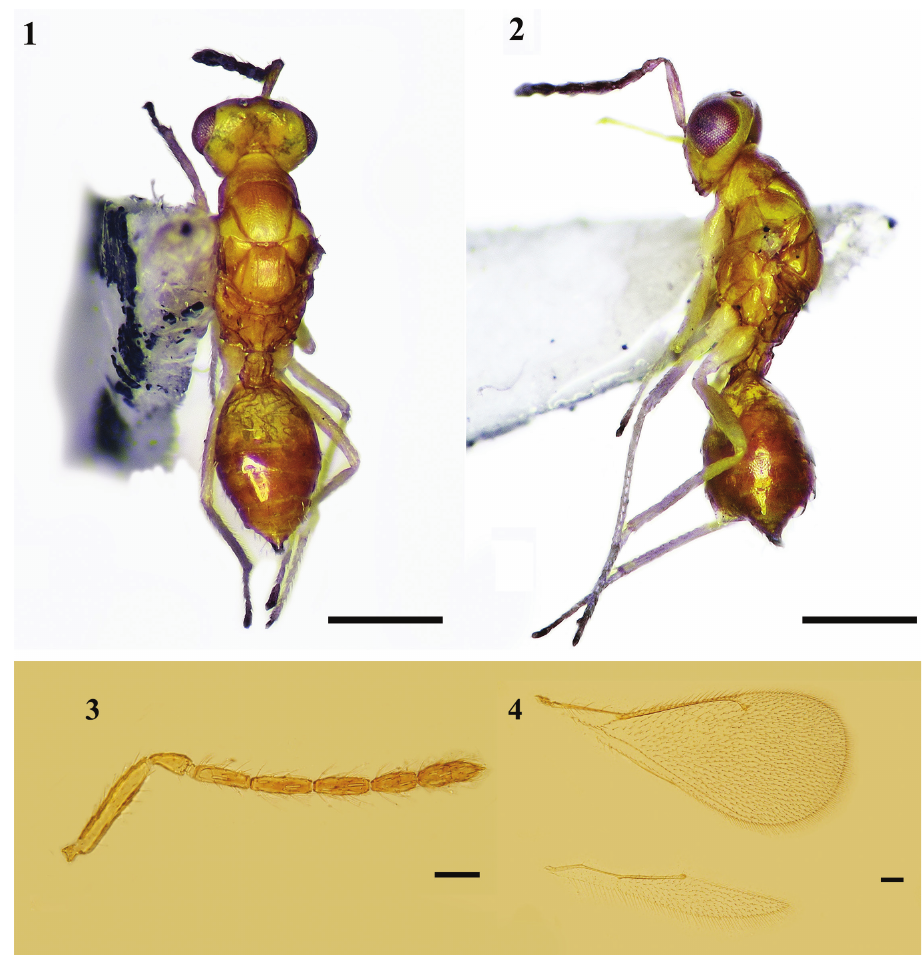
Figures 1–4. Mestocharella qingdaoensis sp. nov., holotype, female 1 habitus, dorsal view 2 habitus, later- al view. Scale bars: 500 μm 3 antenna, lateral view 4 fore and hind wings, dorsal view. Scale bars: 100 cel and flagellum yellowish brown. Metasoma mainly brownish with posterior half of mesoscutum and axillae yellow; wings hyaline, venation yellowish brown; legs yellow, tarsomere IV of all legs dark brown. Mesosoma brownish with basal 1/3 yellowish brown. Head in dorsal view, nearly as broad as mesosoma, 2.5–2.6× (2.5×) as broad as long; vertex with setae shorter than OD, POL 1.3× OOL, OOL 2. × OD. Face de- pressed slightly, without median line; torulus with lower edge above the ventral edge of eyes; eyes separated by 1.45× their height. Malar sulcus present; malar space 0.6× as long as eye height. Mouth cavity 1.4× as wide as malar space; clypeus with anterior margin bidentate; mandible tridentate. Antenna (Fig. 3) scape 5× as long as broad with shorter setae on dorsal and ventral side; two anelli, first anellus slightly transverse, sec- ond anellus lamellar; pedicel 2.2–2.3× as long as broad, shorter than F1; F1–F4: 3.0×,